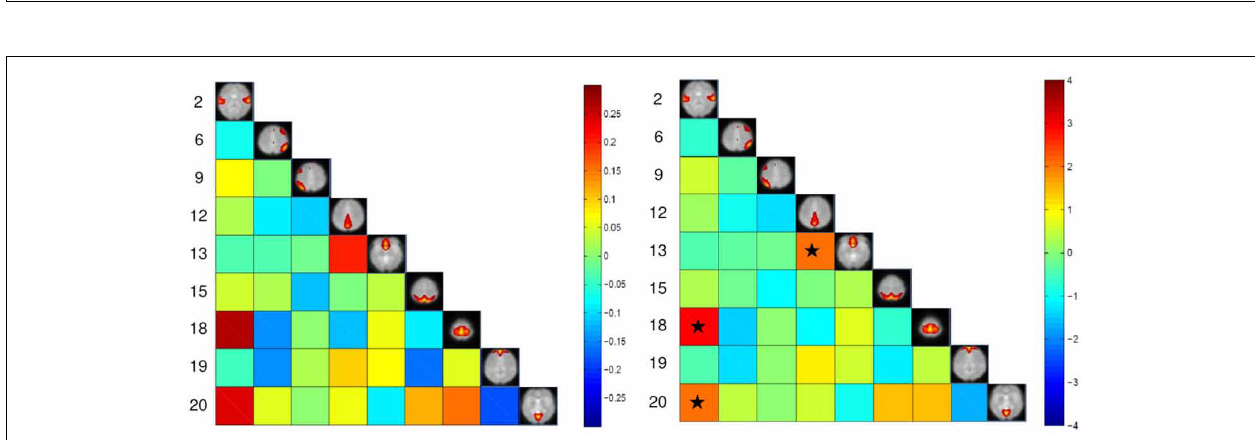
FIGURE 3 | Left: Mean of correlation pairs for controls and patients. Right: T -value of each correlation pair resulted from student t -test with p -value threshold of 0.05 corrected for FDR. Black circles indicate the pairs surviving the t -test.